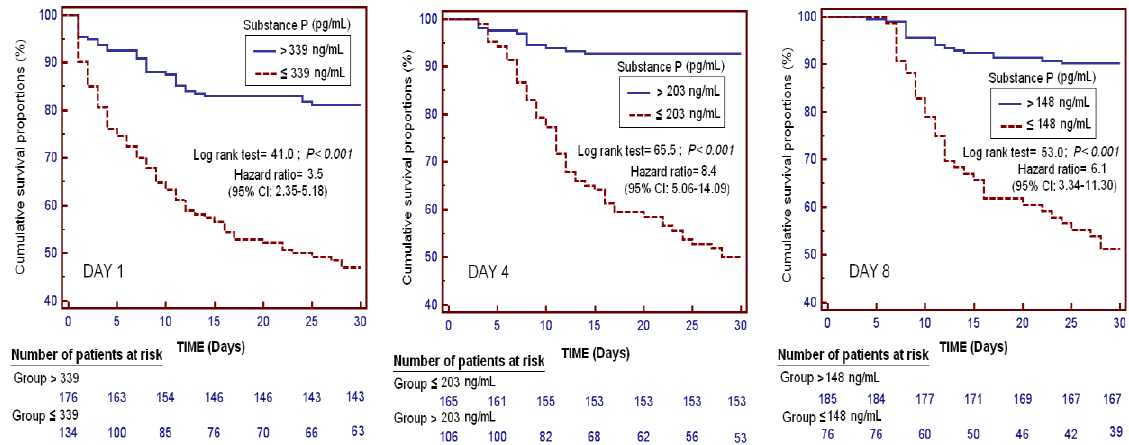
Figure 3. Survival curves at 30 days using serum substance P levels higher or lower than 339 pg/mL.